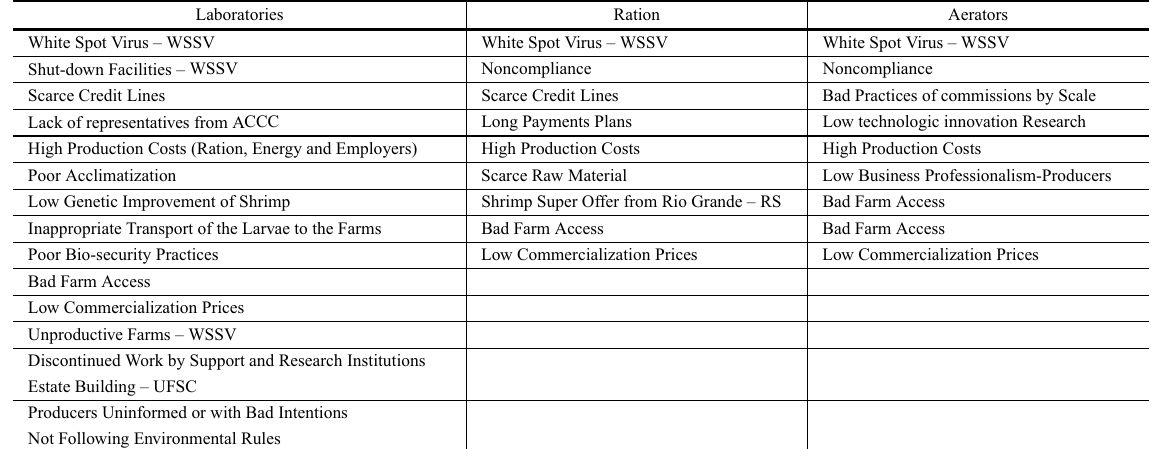
TABLE II Possible obstacles in the local productive